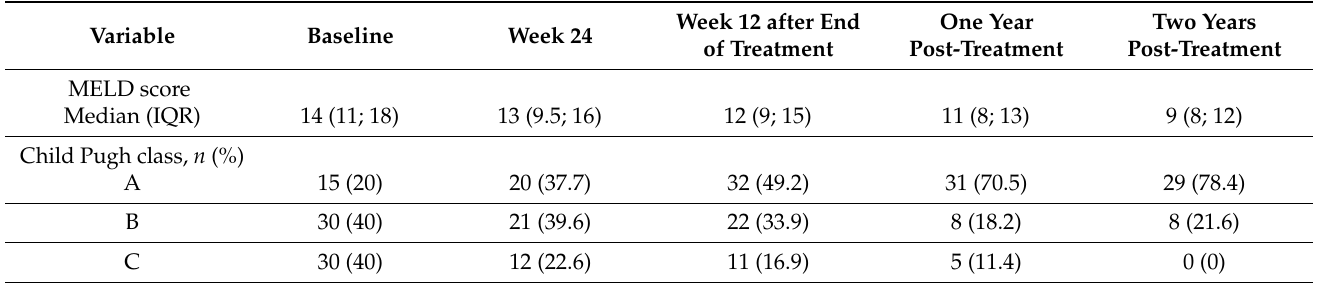
Figure 2. ( A ) Overall survival and ( B ) Transplant-free survival among patients awaiting LT listed for HCC ( n = 104) or decompensated cirrhosis ( n = 75) since HCV treatment. Table 2. Hepatic function outcomes during and after HCV treatment in patients awaiting LT for decompensated